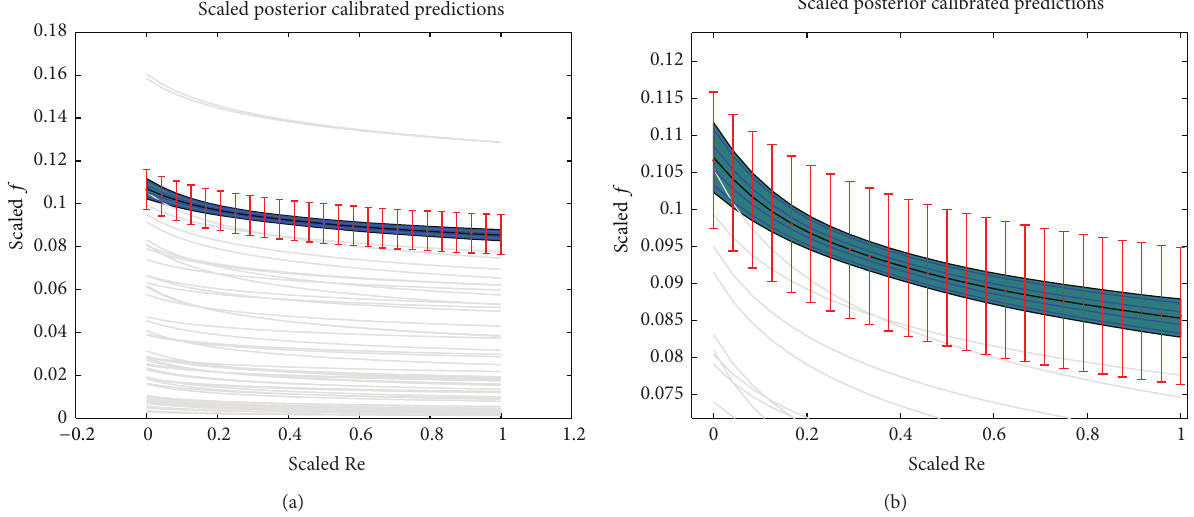
Figure 10: FFGP 2-factor 2-component calibrated posterior predictions ((a) covers entire training set; (b) zoom in on the observational data).